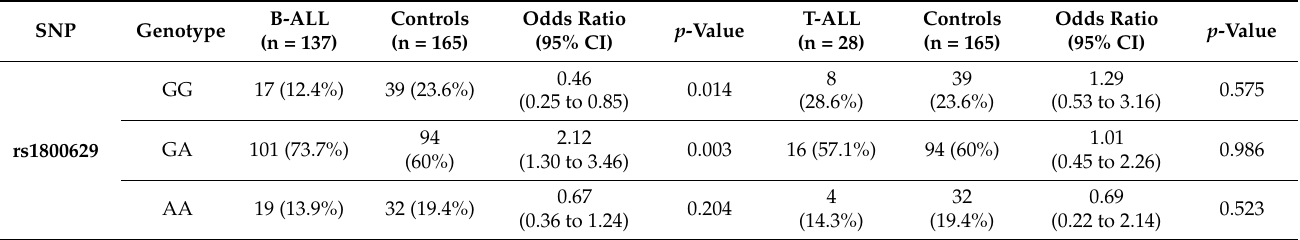
Table 3. Genotype distribution of rs1800629 in the B–ALL/T–ALL cases and control group.